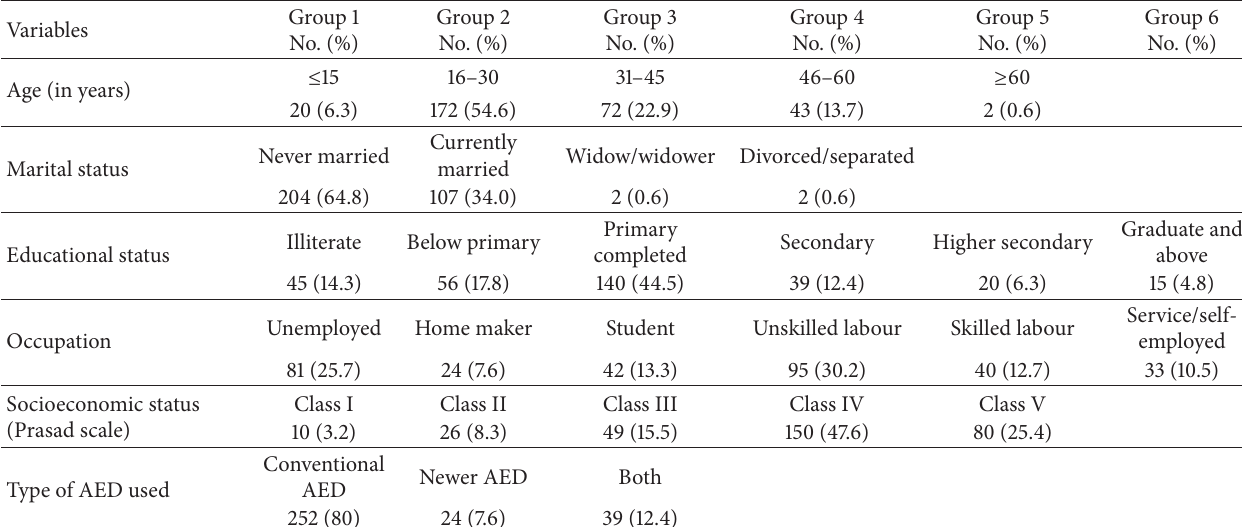
Table 1: Baseline information of the study population ( 𝑛 = 315 ).